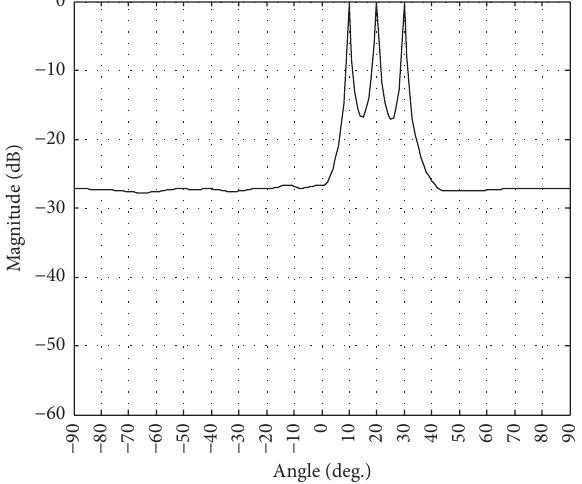
Figure 4: The spectrum search results of RD-NC-Capon algorithm (SNR = 20 dB, 𝑀 = 8 , 𝐿 = 200 , and 𝐾 = 3 ).